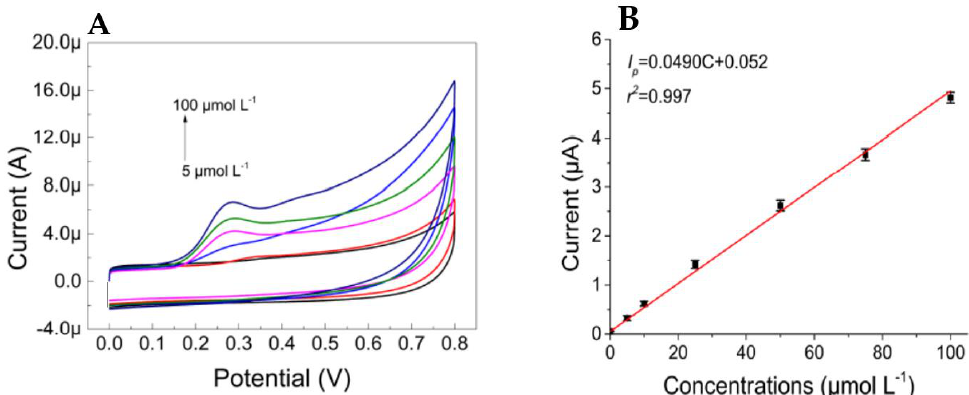
Figure 6. ( A ): CV responses from mag–MIP/Gr–UiO66/SPE at different CBD concentrations and ( B ): the linear relationship between peak current and CBD concentration. Reprinted and adapted from ref. [52]. Copyright 2022 Multidisciplinary Digital Publishing Institute